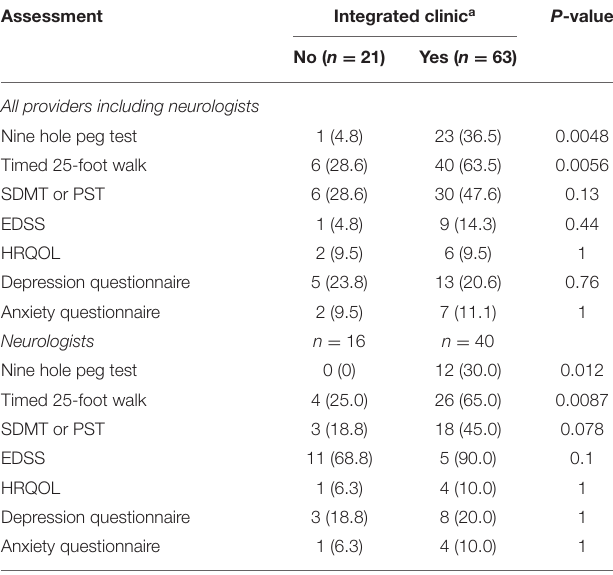
TABLE 3 | Percentage of assessments routinely performed stratified by whether the health care provider is in an integrated multiple sclerosis clinic or not.